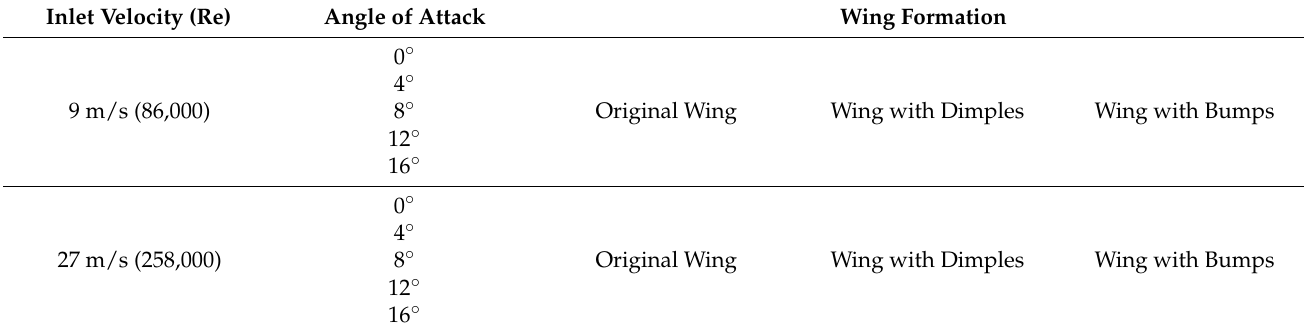
Table 5. Cases of the numerical